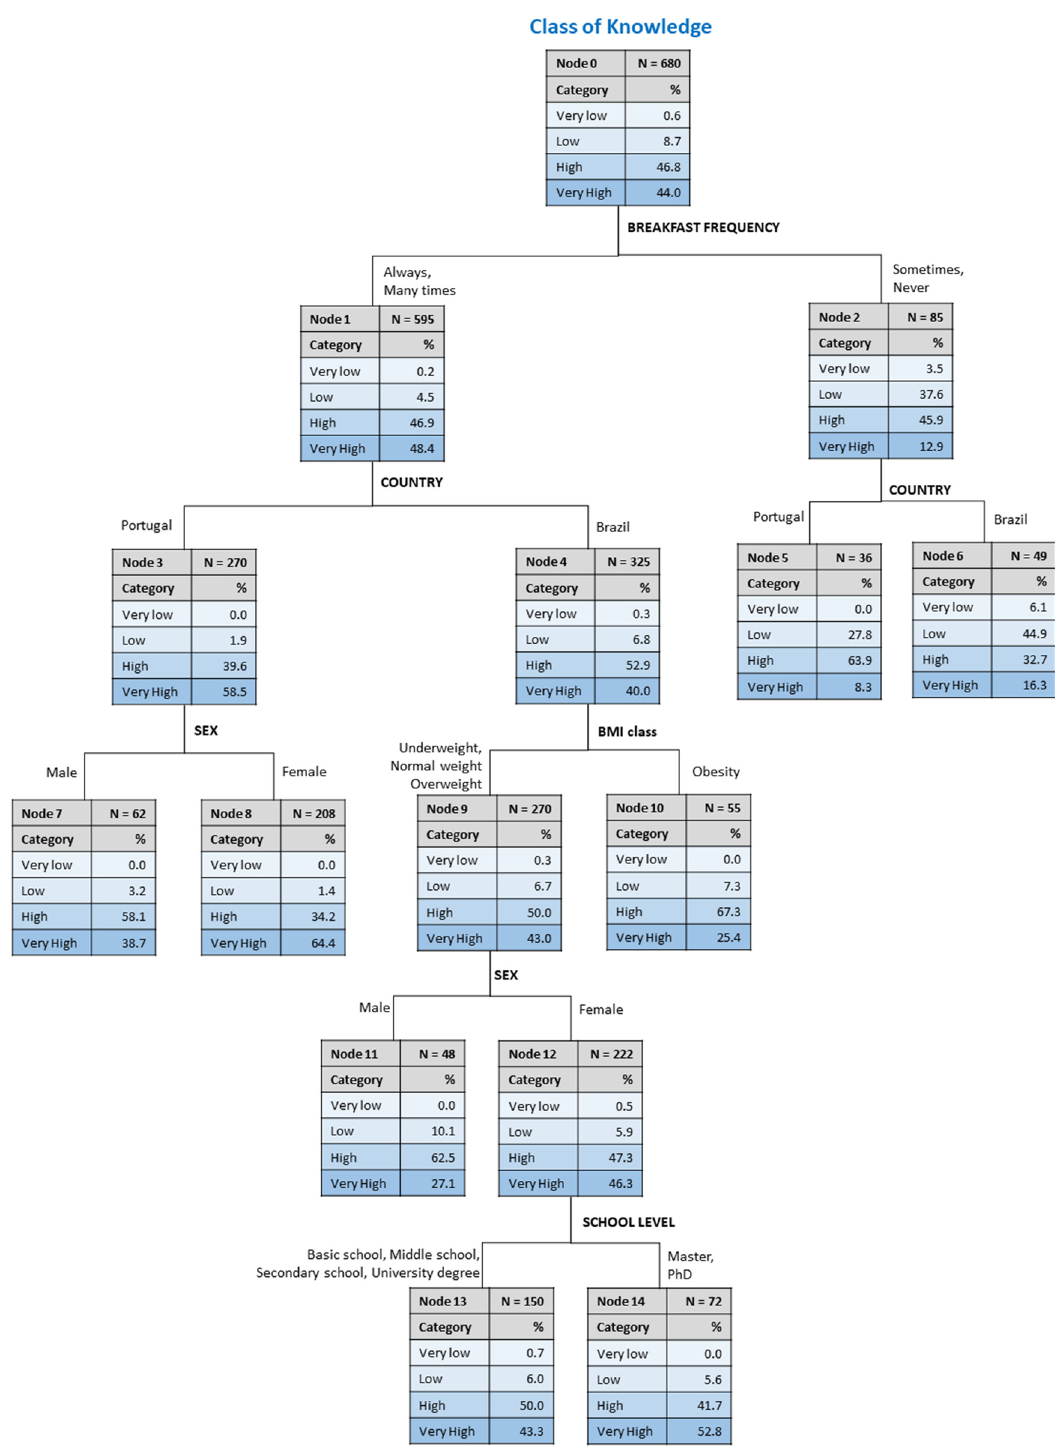
Figure 9: Classi fi cation tree for the level of